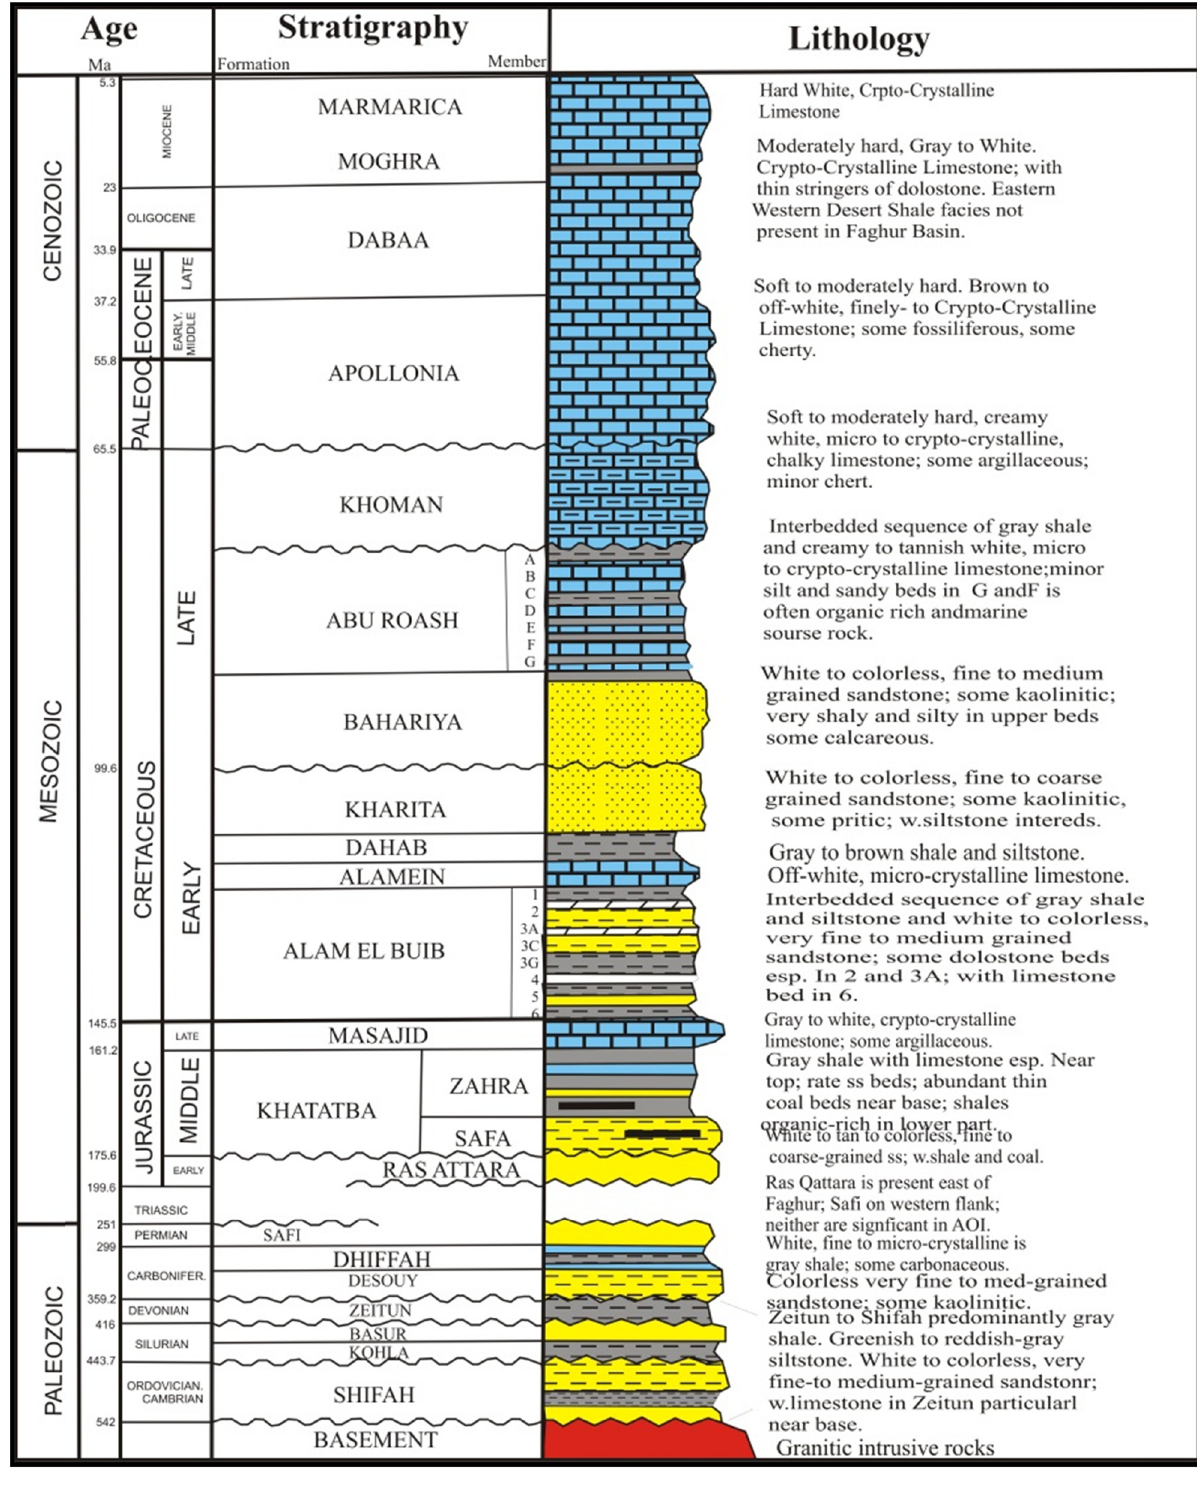
Figure 2: Generalized lithostratigraphic column of the Western Desert of Egypt. Modi fi ed after Mohamed ( 2016 )